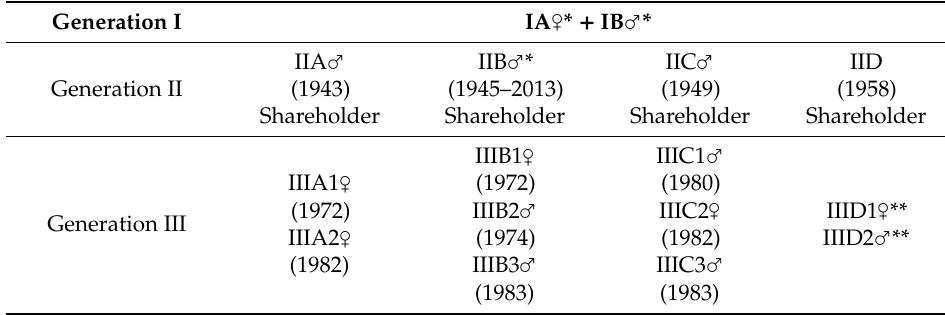
Table 4. Family tree and